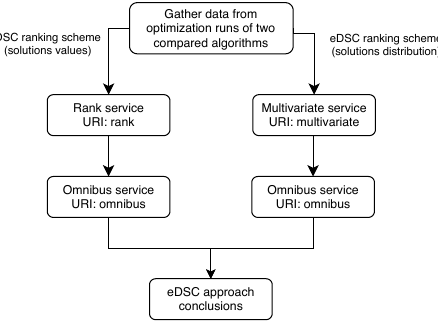
Figure 1. Extended Deep Statistical Comparison